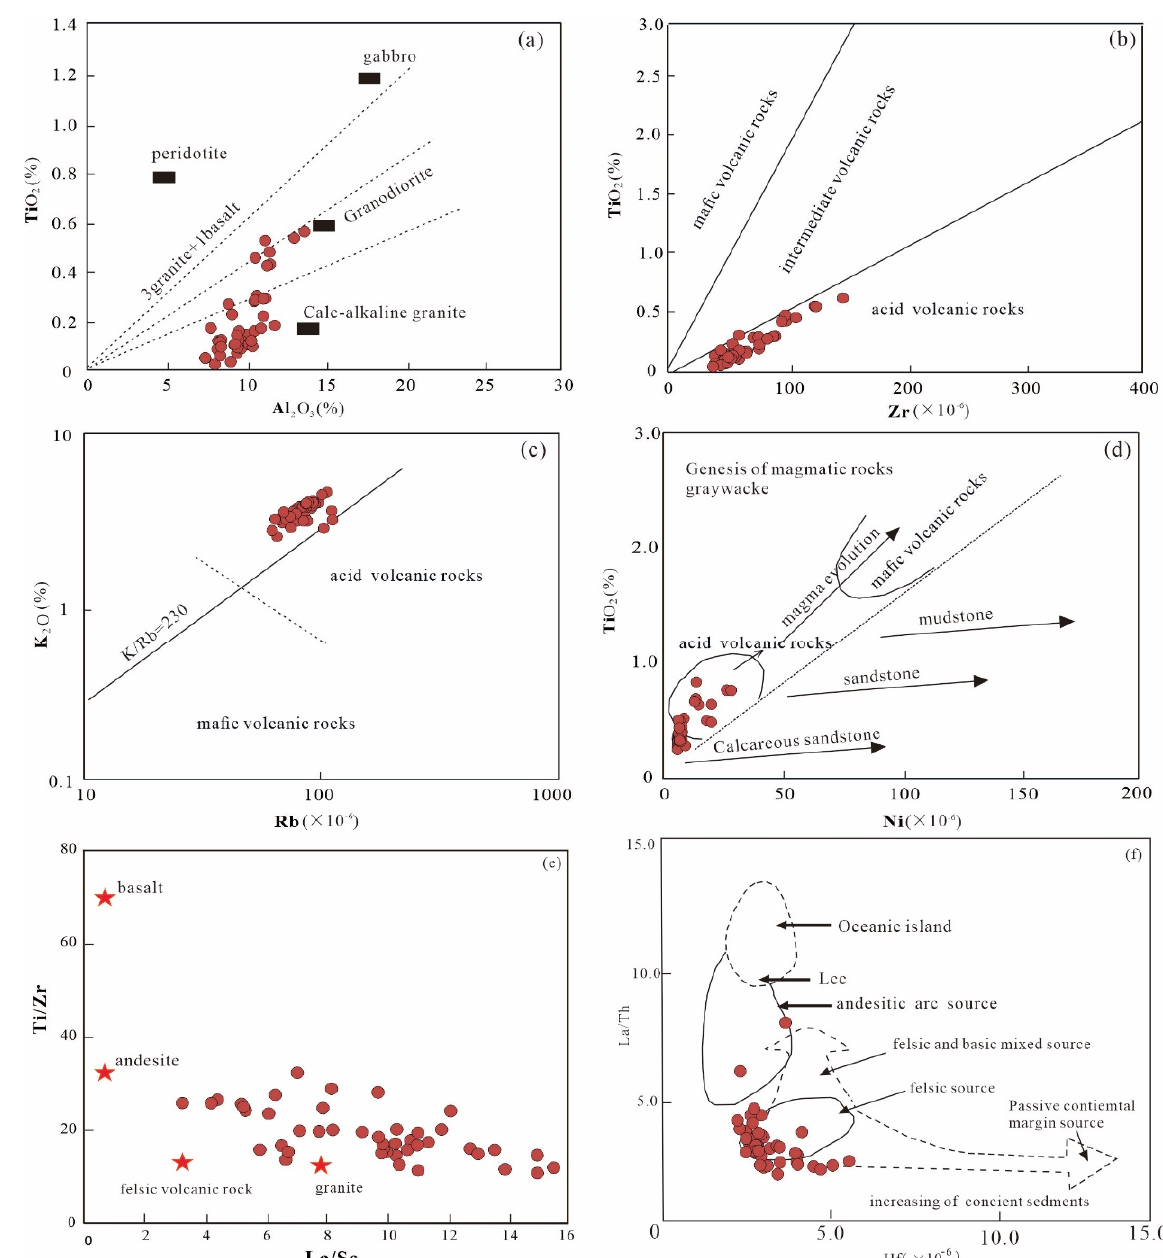
Figure 10. Discriminant diagram of source rock properties of major and trace elements in Sifang Formations in the northern Songliao Basin. ( a ) TiO 2 -Al 2 O 3 (after Schieber [51]), ( b ) TiO 2 -Zr (afte Hayashi et al. [52]); ( c ) Rb-K 2 O (after Floydand Leveridge [53]); ( d ) Ni-TiO 2 (after Floyd [54]); ( e ) Ti/Zr-La/Sc and ( f ) La/Th-Hf(after Bhatia and Crook [55]).